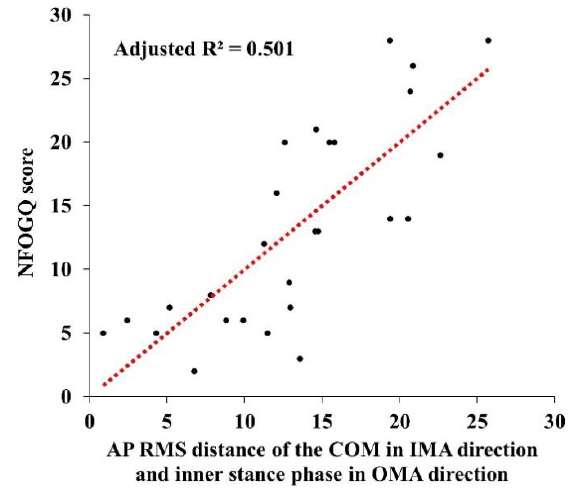
Figure 5. Associations between NFOGQ scores and turning characteristics for freezers during the 180° turning task. Tendency of regression line indicates positive linear correlation of corresponding correlation coefficient; NFOGQ, New Freezing of Gait Questionnaire; AP, anteroposterior; RMS, root mean square; COM, center of mass; IMA, inner step of the more affected limb; OMA, outer step of the more affected limb. Table 4. Association between NFOGQ scores and turning characteristics for freezers during the 180° turning task.